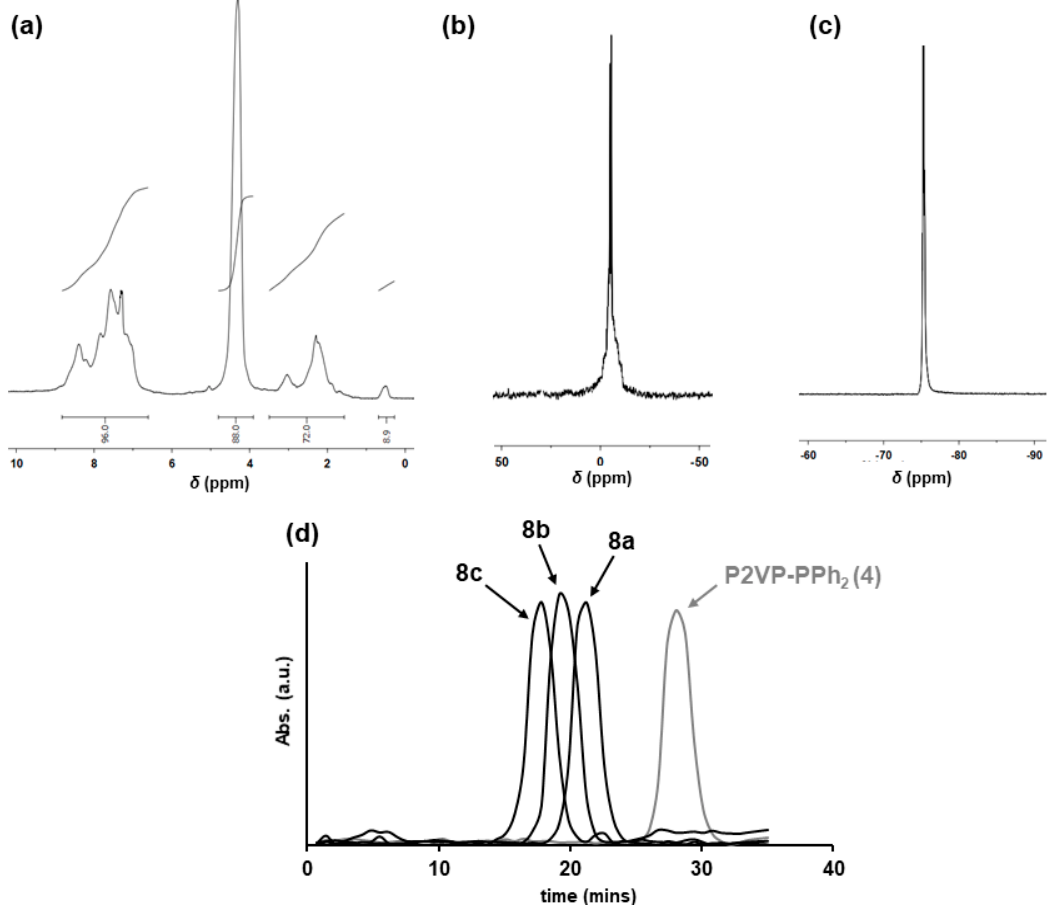
Figure 2. NMR spectra of BCP 8a : ( a ) 1 H-NMR; ( b ) 31 P-NMR; ( c ) 19 F-NMR. ( d ) UV-GPC trace of